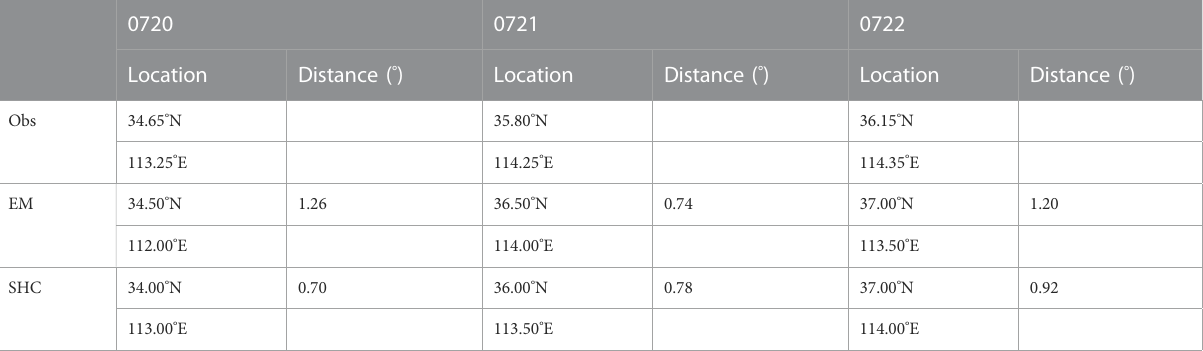
TABLE 5 Locations of maximum precipitation and their differences in distance when comparing data from SHC (or EM) and observation in subplot (see Figure 5).